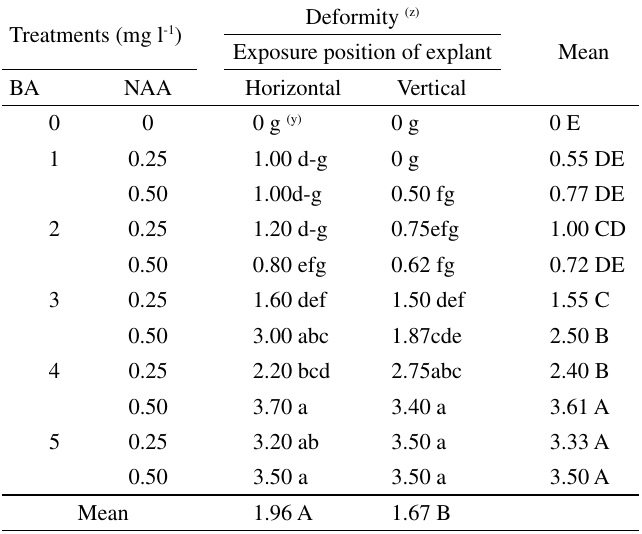
Table 6 - The interaction effect of different concentrations of BA and NAA, and exposure position of explants on deformity in ‘Green’ Treatments (mg l -1 )